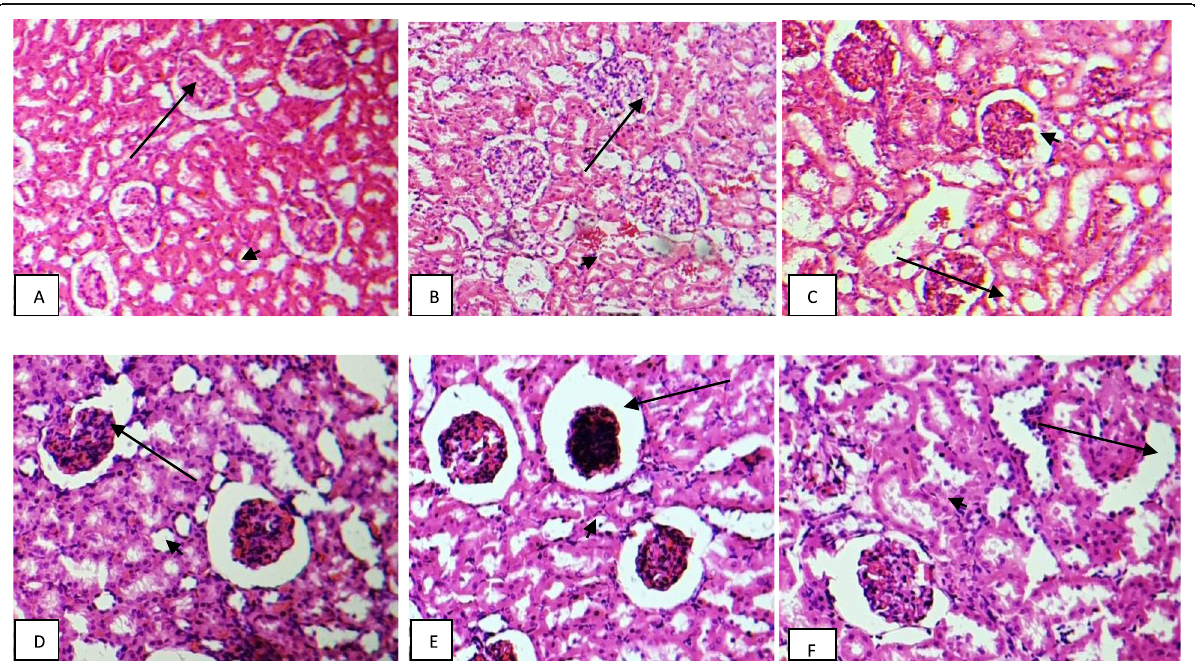
Fig. 2 Effect of n-Hexane leaves extracts of J. gossypiifolia on the kidney. A = untreated group: Kidney reveals visible renal corpuscle and interstitial space and tubules showing tubular necrosis. B = 10 mg/kg Gliberclamide: Kidney reveals visible renal corpuscle and interstitial space and tubules with diffused mononuclear infiltrate. C = Normal control: Kidney reveals visible renal corpuscle and interstitial space and tubules. D = 30 mg/kg extract: Kidney reveals visible atrophied renal corpuscle with distortion in the tubules. E = 50 mg/kg extract: Kidney reveals visible atrophied renal corpuscle with distortion in the. F = tubules and mononuclear infiltrates. 100 mg/kg extract: Kidney reveals visible slightly atrophied renal with mild tubular necrosis and mild mononuclear infiltrates. Using haematoxylin-eosin dye with X 40